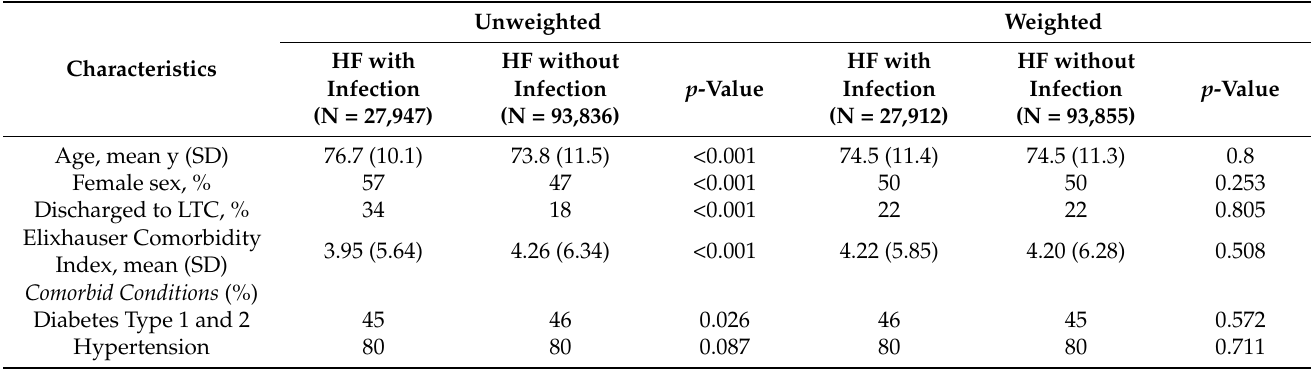
Table 1. Baseline characteristics before and after inverse probability of treatment